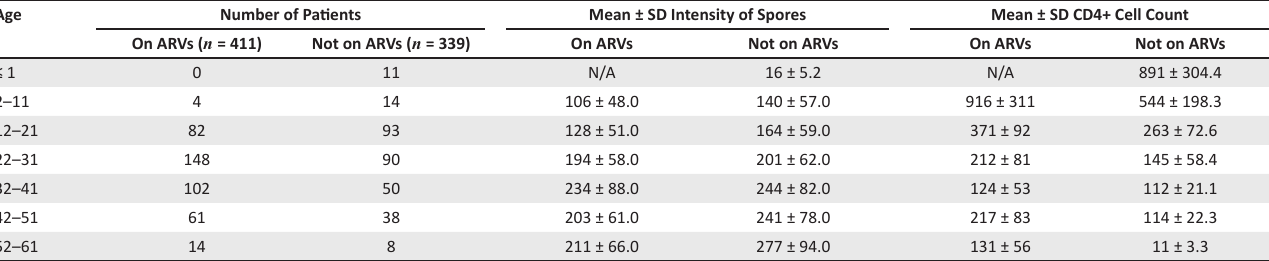
TABLE 3: Intensity of Microsporidium spores in relation to age, CD4+ count and antiretroviral therapy status amongst HIV-positive patients ( n = 750). Age Number of